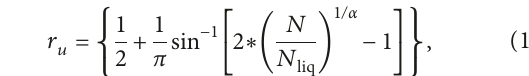
Figure 10: (a) Pore-water pressure ratio (PWP) versus cycle ratio number ( N / N water pressure ratio (PWP) versus number of cycles ratio ( N / N L ) obtained by using α coefficients from the model proposed by Seed et al.